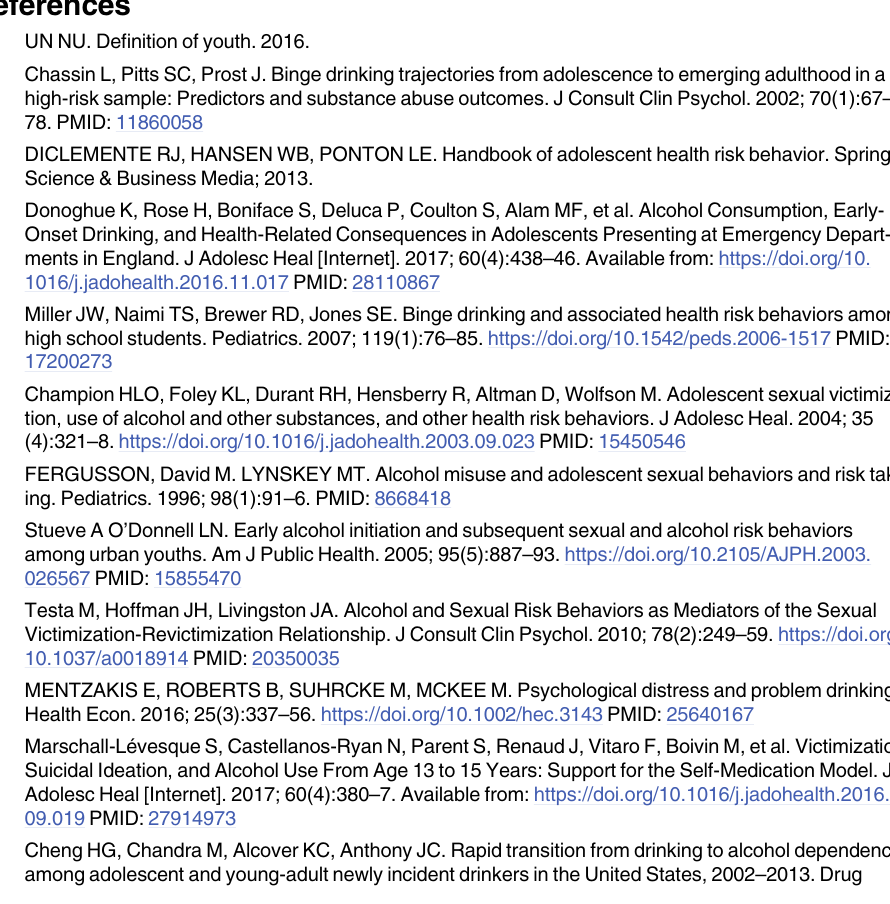
S3 Table. Brant [56] test results. Source: Prepared by the authors based on information from PeNSE 2015. S4 Table. Description of the sample by alcohol consumption categories. Source: Prepared by the authors based on information from PeNSE